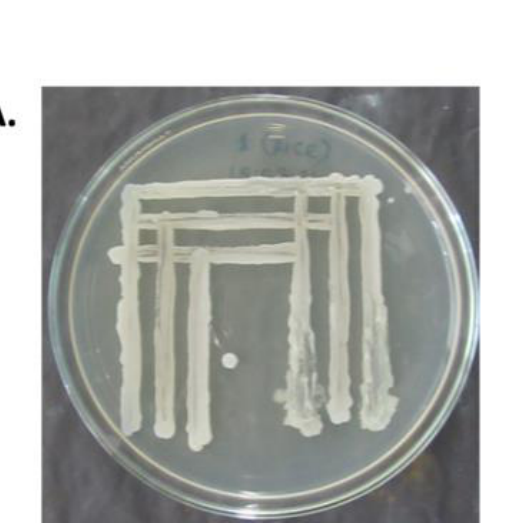
Figure 2. ( A ) Pure culture of BDISO76MR, an isolate obtained from maize rhizosphere, and ( B ) PCR amplification of 16S rDNA of BDISO76MR using 27F and 1518R primers (M = DNA marker; W = Water).